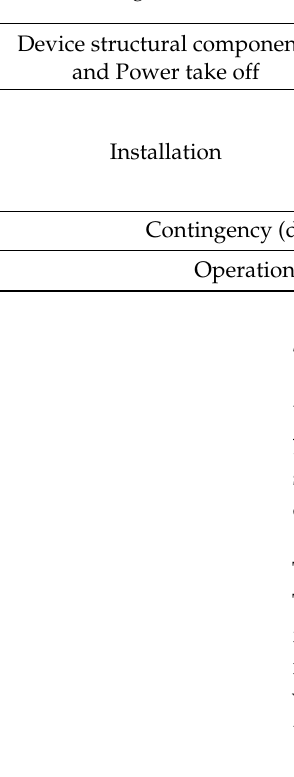
Table 5. Technology specific assumptions used in tidal stream case study.